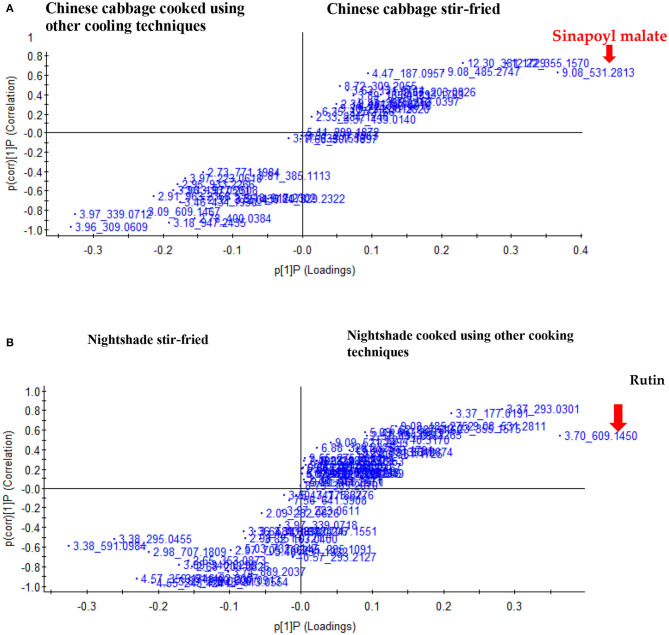
Score plot of orthogonal partial least squares discriminant analysis of UHPLC-QTOF/MS spectra and the marker compounds for the separation of stir-fried leaves of (A) Chinese cabbage (Brassica rapa L. subsp. chinensis) and (B) nightshade (Solanum retroflexum Dun) from the other household cooking techniques.